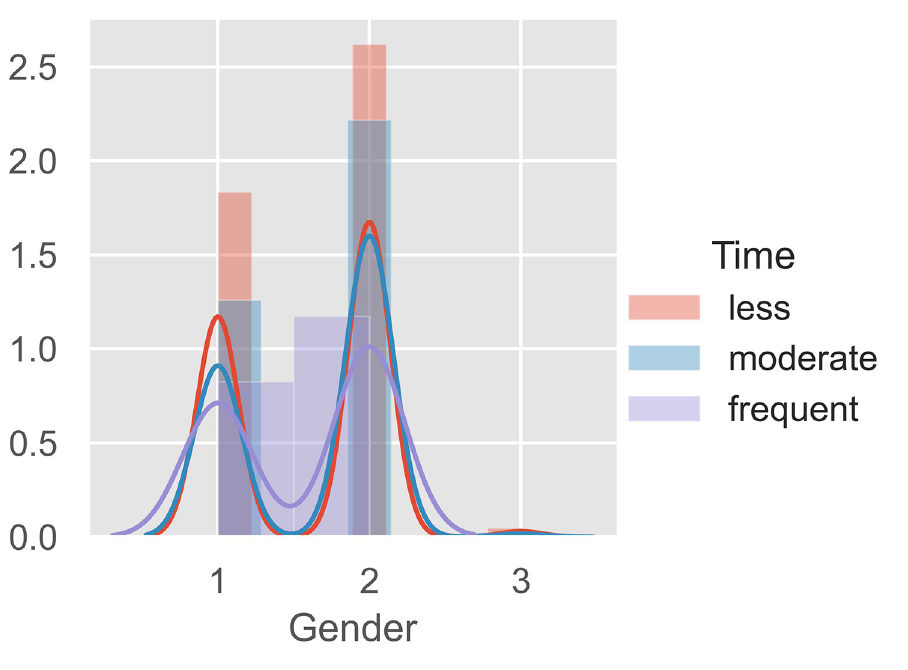
Fig 4. Cluster visualization through gender.